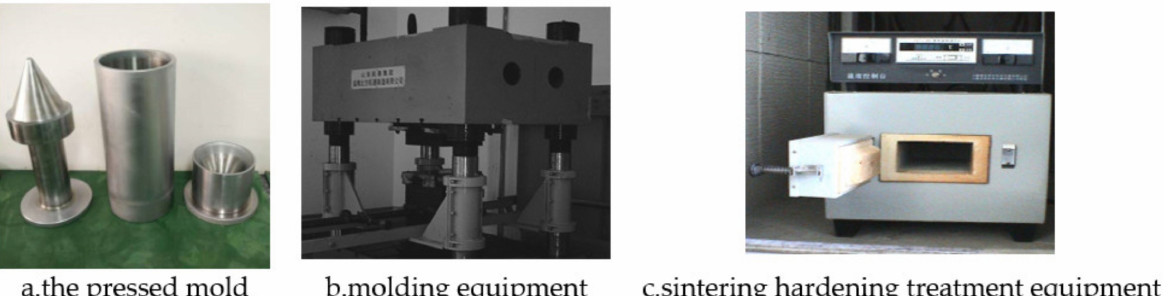
Figure 2. Molding equipment ( a , b ) and sinter hardening treatment equipment ( c